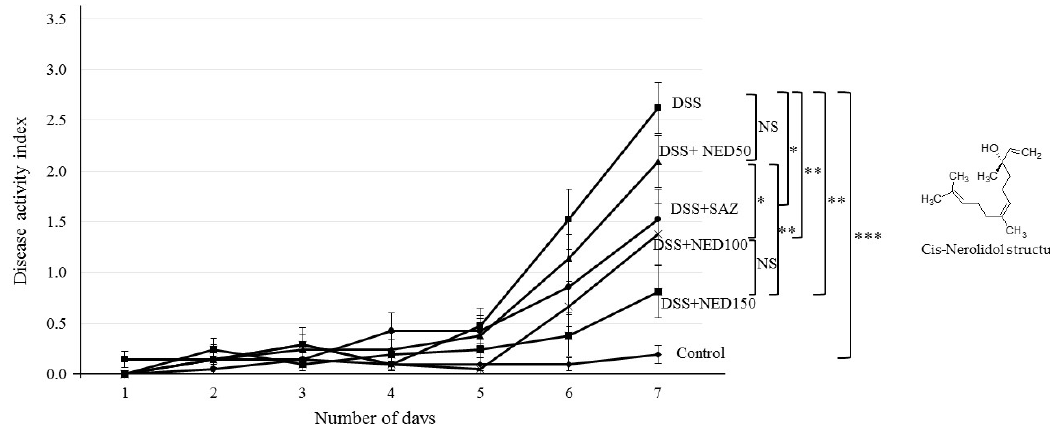
Figure 1. Effect of Nerolidol (NED) on disease activity index (DAI). Dextran sodium sulfate (DSS) treatment significantly increased the DAI score. Sulfasalazine (SAZ) and the higher concentrations of NED significantly prevented the increase in DAI scores induced by DSS. However, the lowest dose of NED (50 mg/kg) treatment had no effect. Data were obtained from n = 10 animals in each group and are expressed as mean ± SEM. *** p ≤ 0.001. ** p ≤ 0.01. * p ≤ 0.05. P values were obtained by one-way ANOVA followed by Tukey’s multiple comparison test using SPSS software, and p ≤ 0.05 was considered statistically significant.